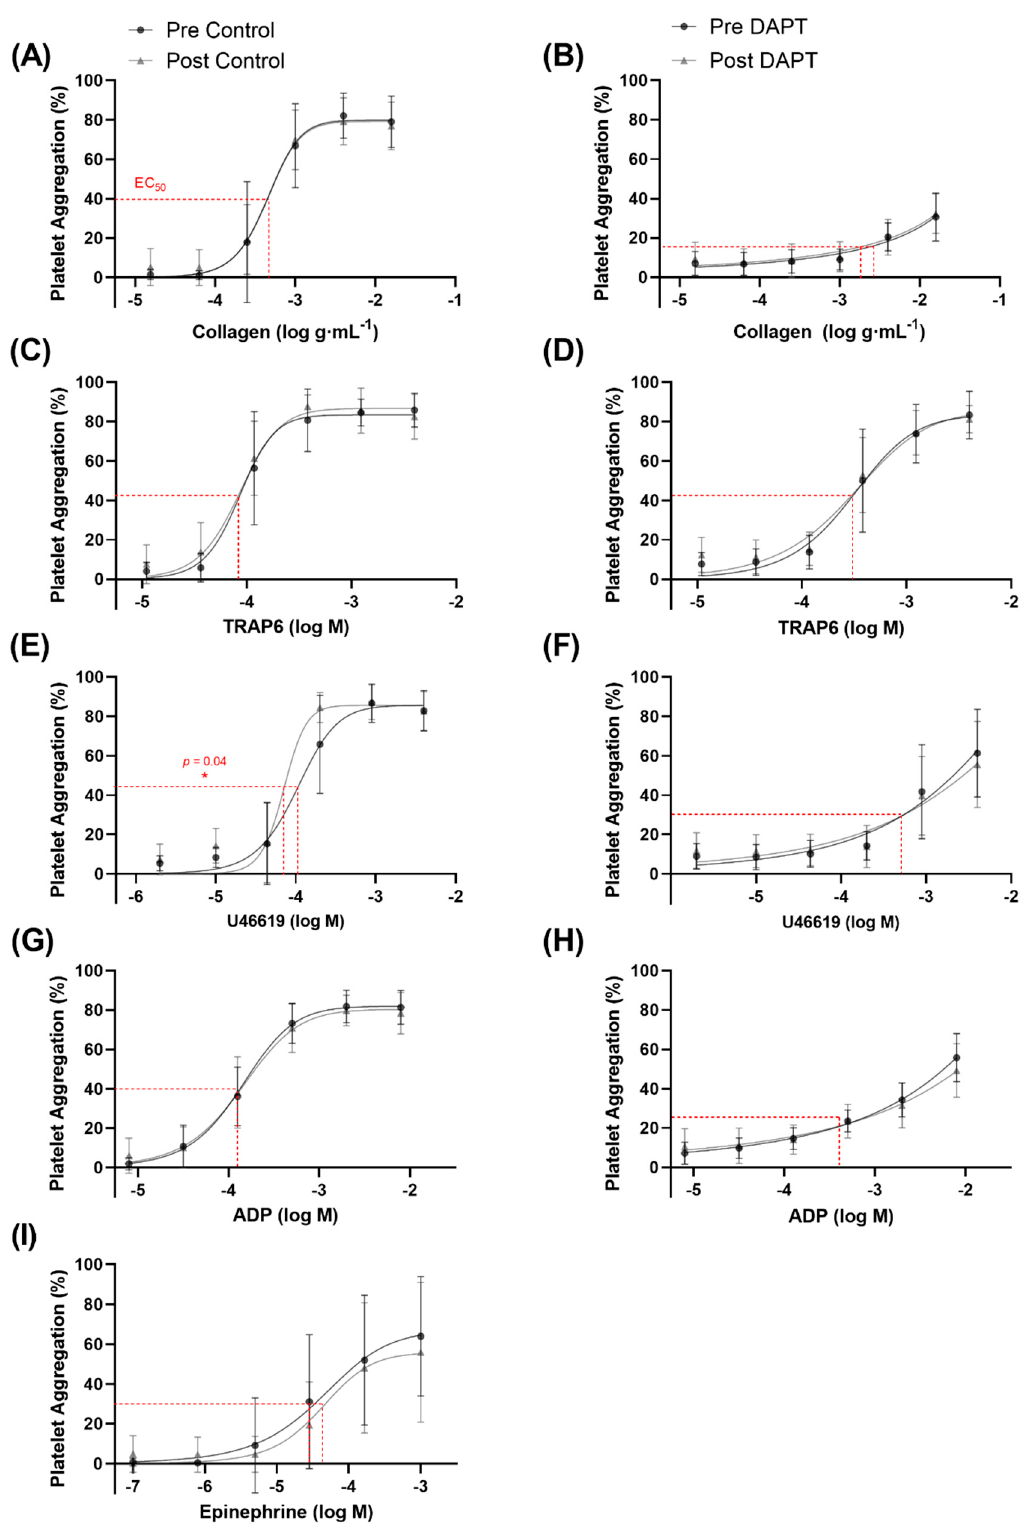
Figure 3. The half maximal effective concentration (EC 50 ) for platelet aggregation with ( B , D , F , H ) or without ( A , C , E , G , I ) dual anti-platelet therapy (DAPT): ( A ) collagen, ( B ) collagen with DAPT, ( C ) thrombin receptor activator peptide 6 (TRAP6), ( D ) TRAP6 with DAPT, ( E ) U46619, ( F ) U46619 with DAPT, ( G ) ADP, ( H ) ADP with DAPT, and ( I ) epinephrine. *, indicates a statistically significant decrease with training ( n = 13 for all agonists).